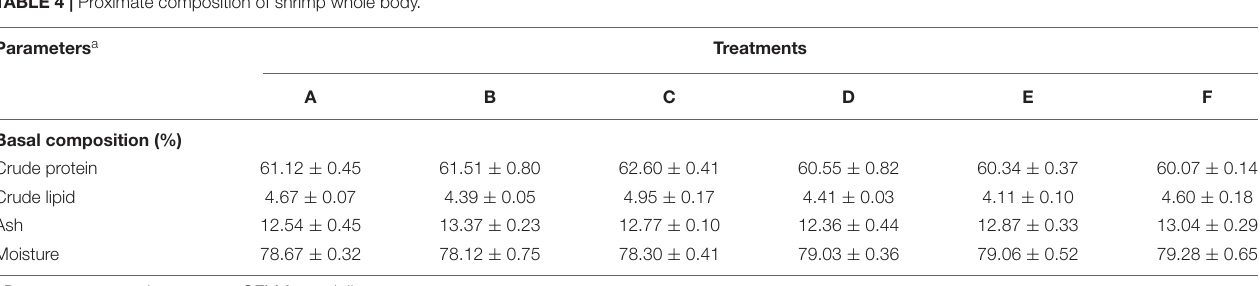
TABLE 4 | Proximate composition of shrimp whole body.